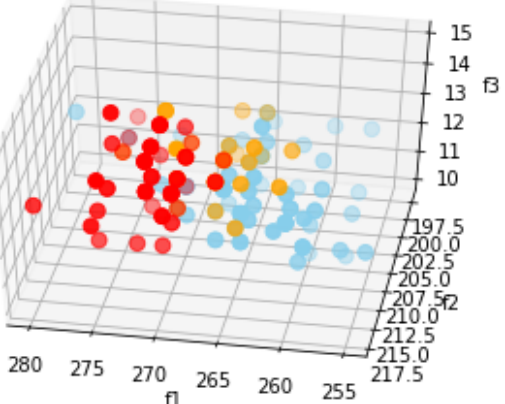
Figure 7. Training features extracted from heat sensor images of the office space when it is in three different states. Blue data points: features of the empty office recordings, orange data points: features of the office recordings when it is occupied by one person, red data points: features of the office recordings when it is occupied by two